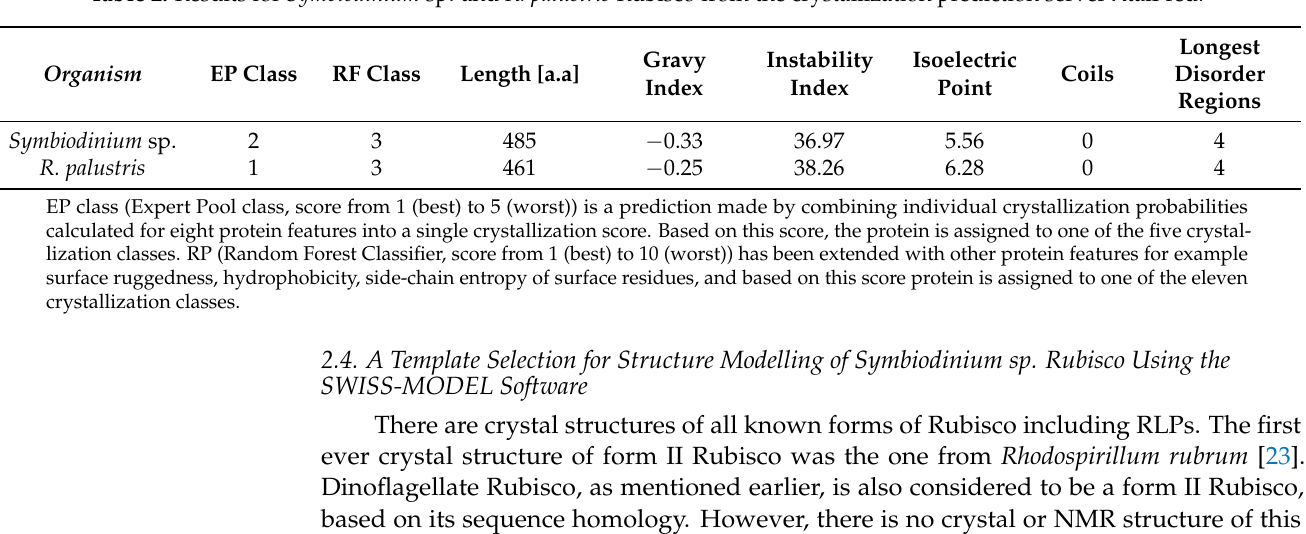
Longest Gravy Instability Isoelectric Coils Disorder Index Index Point Regions